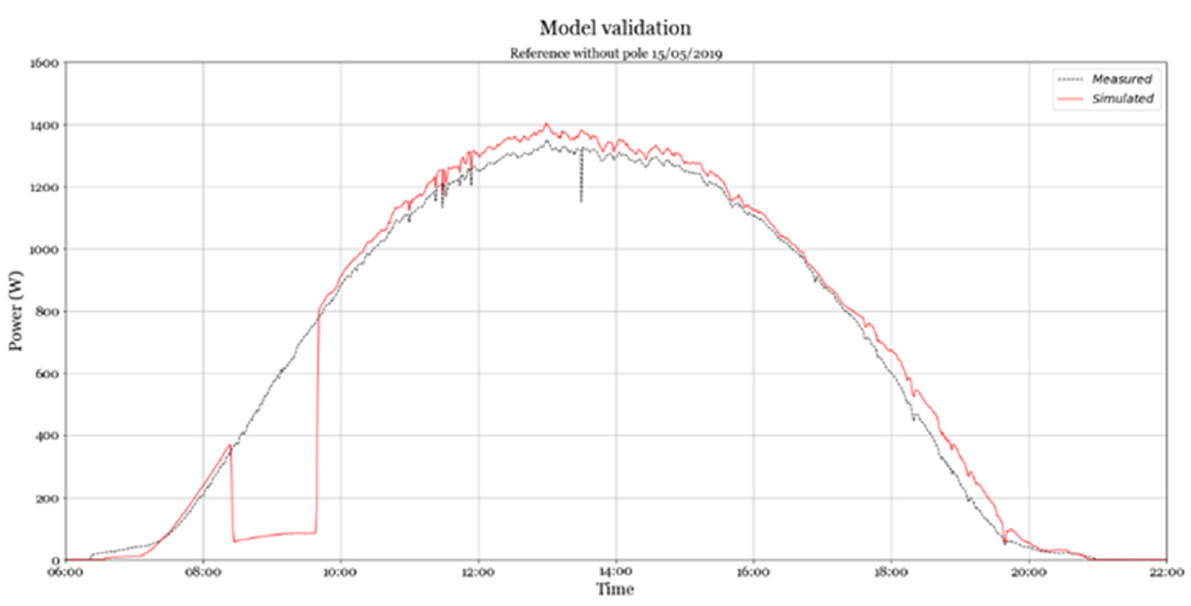
Figure 12. Simulated and measured power output for a sunny day.